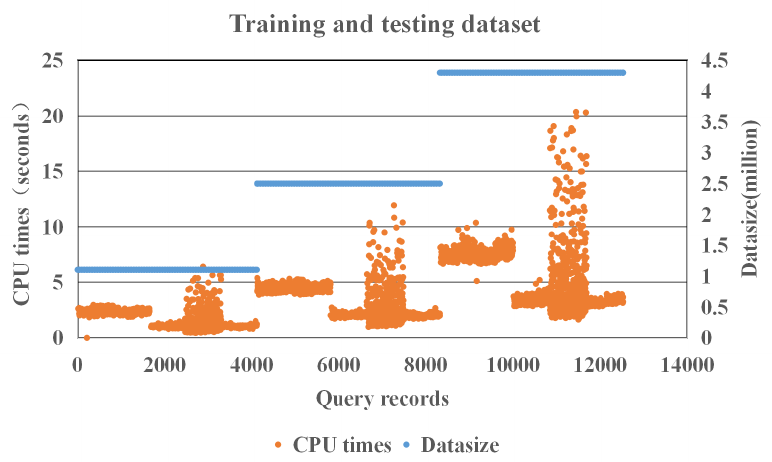
Figure 3. The CPU time distribution of training and testing data sets.